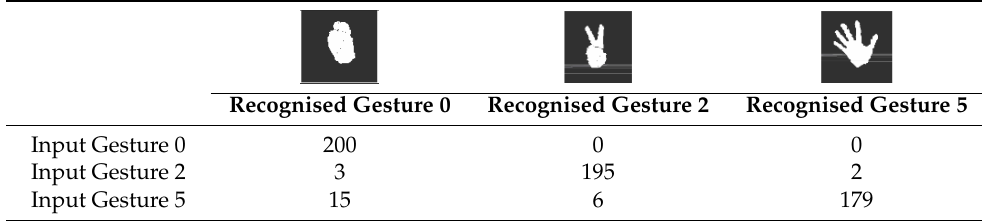
Confusion matrix computed during the recognition process for the identification of three simple gestures of the right hand, with 200 samples per gesture.